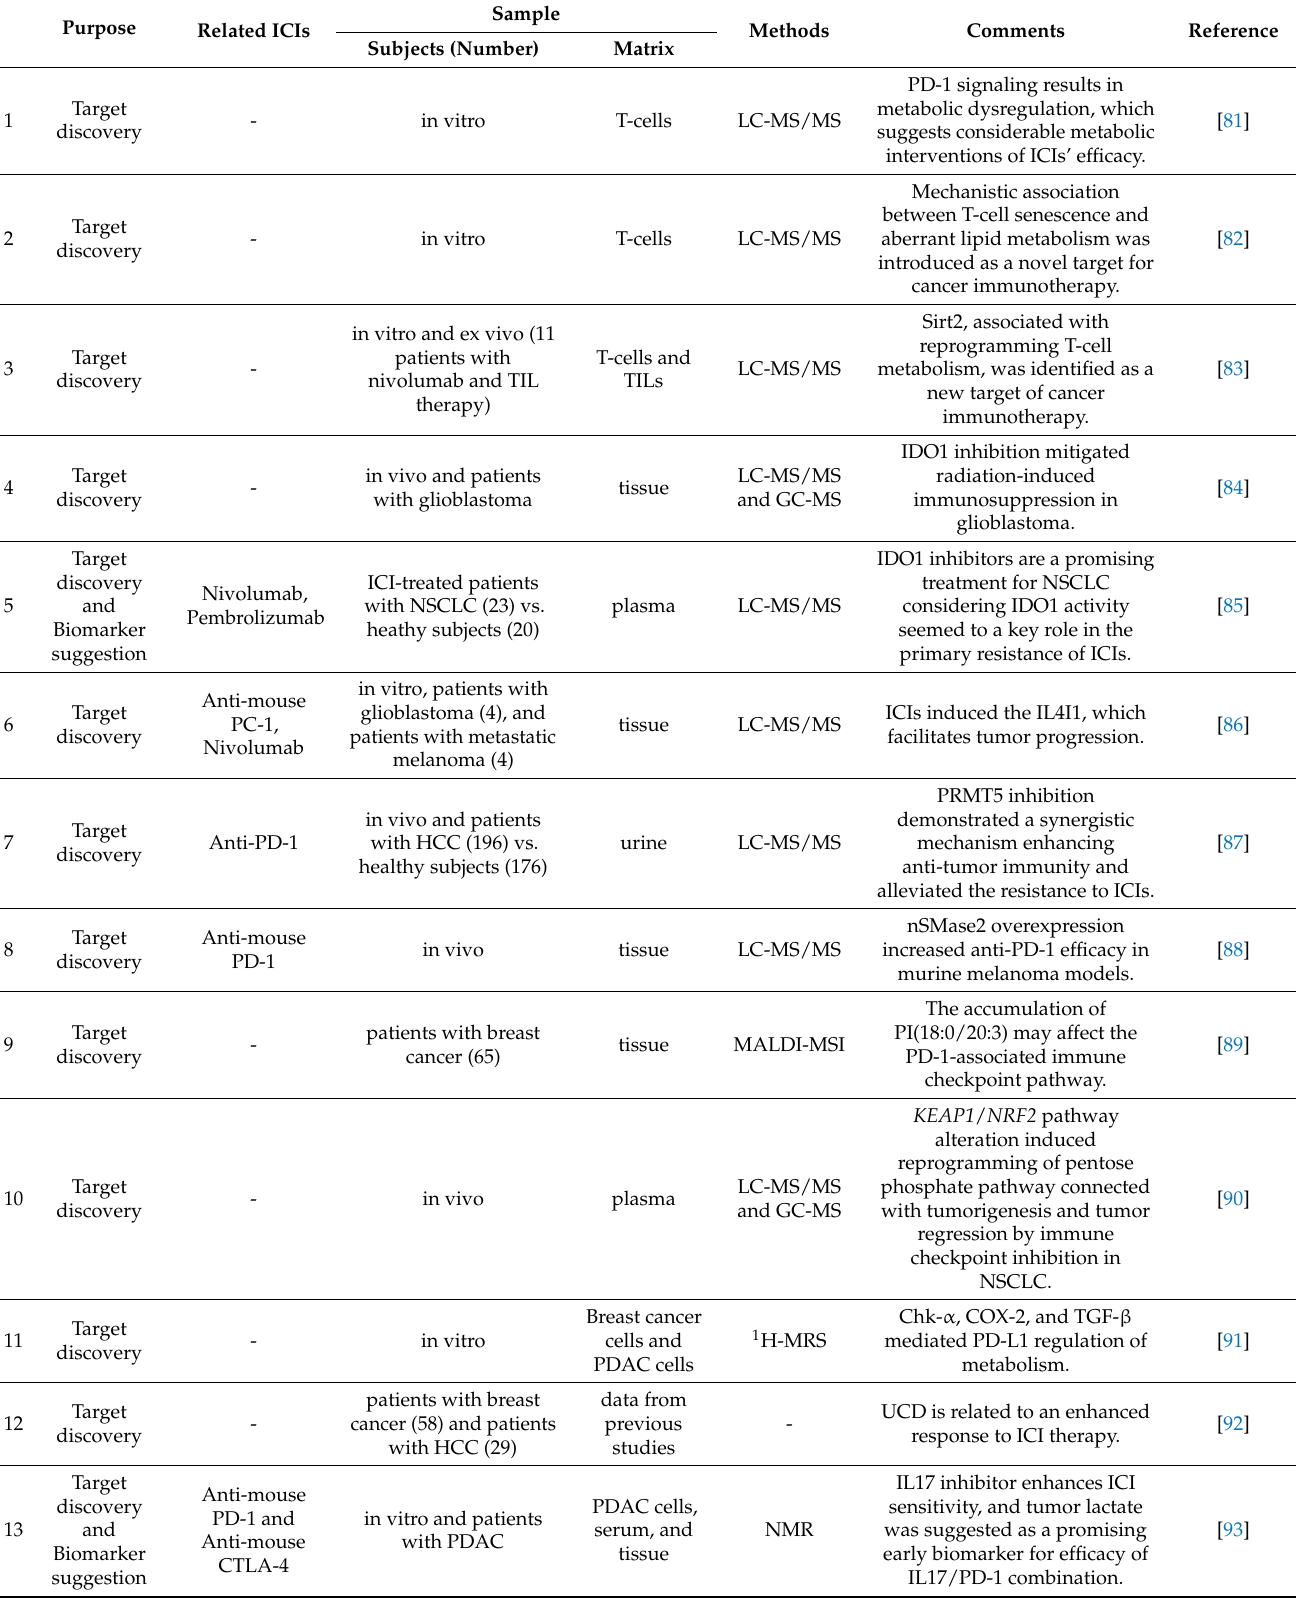
Table 3. Metabolomics-based studies related to ICIs or focusing on the development of